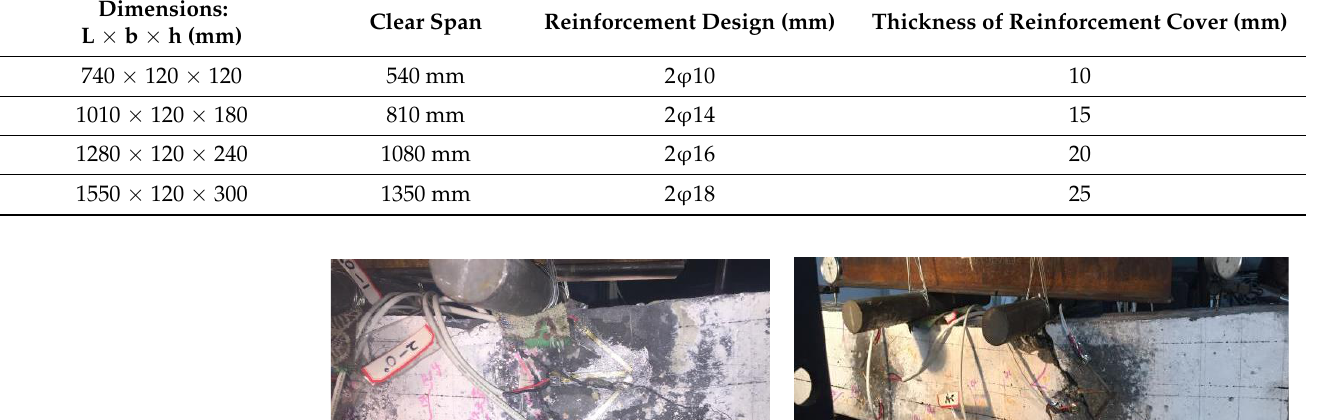
Table 5. Beam size and reinforcement design.